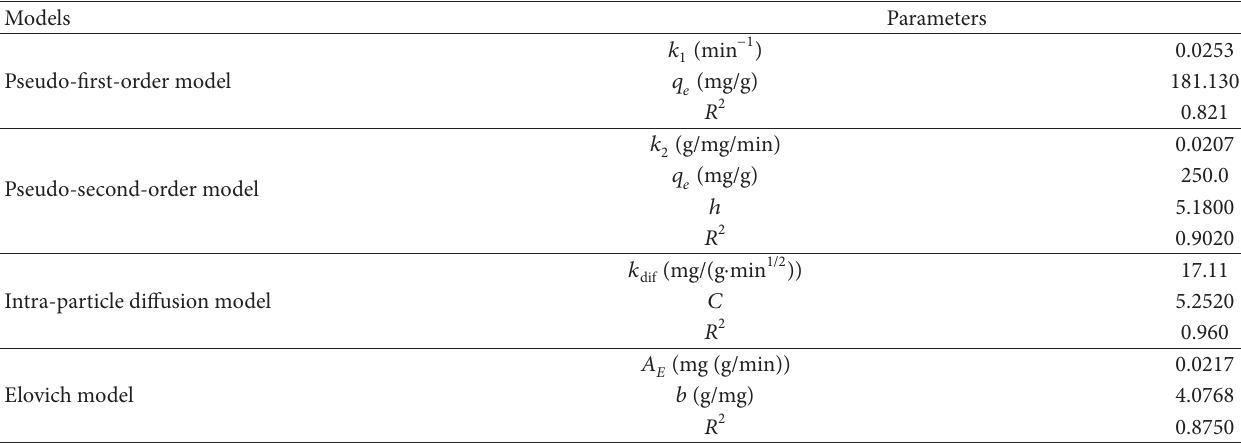
T 5: Comparison of the correlation coefficients of kinetic parameters for the adsorption of Ni 2+ ions onto ZLRC.